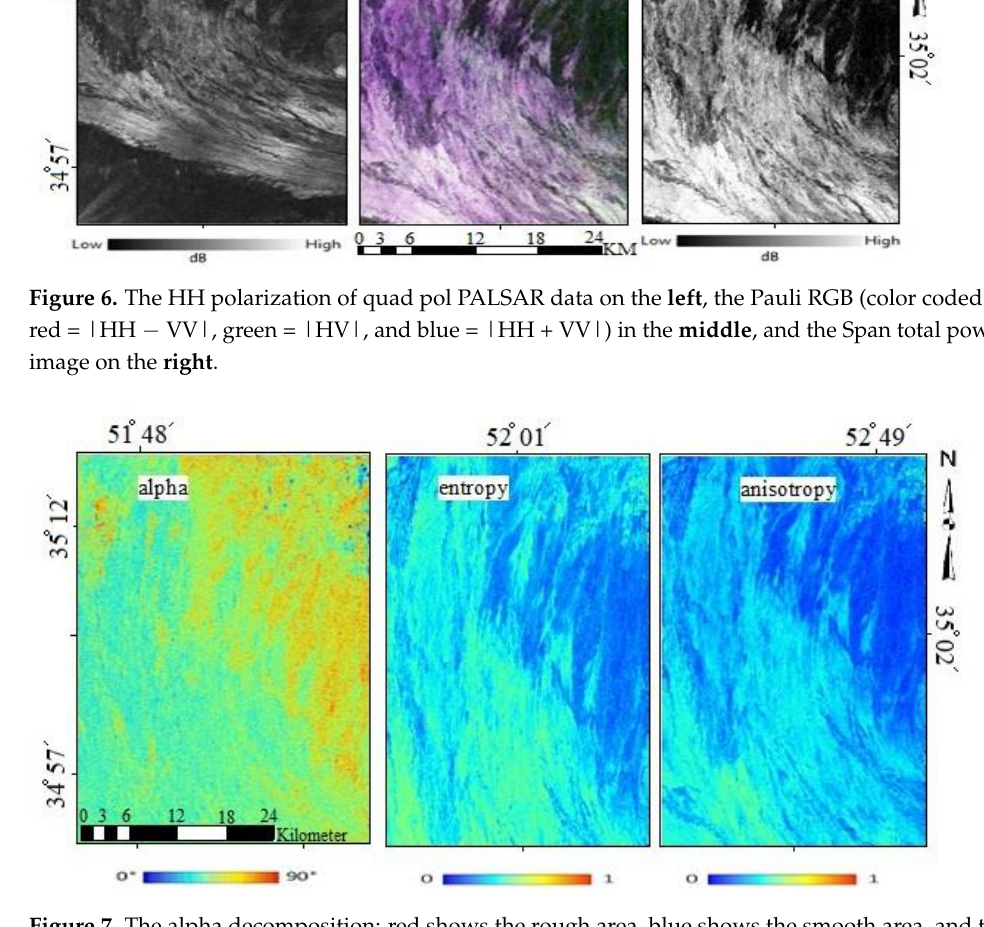
Figure 7. The alpha decomposition: red shows the rough area, blue shows the smooth area, and the moderate is shown in green on the left ; the entropy image is in the middle ; and the anisotropy image moderate is shown in green on the left; the entropy image is in the middle; and the anisotropy in the right image in the right.